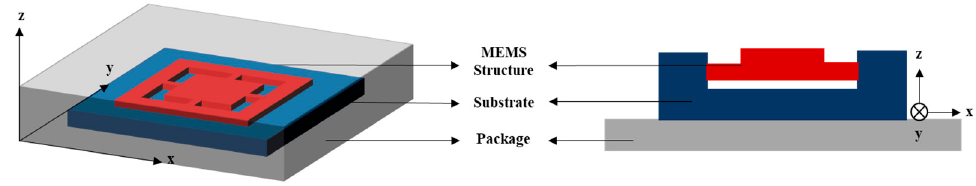
Figure 2. Package-substrate-microstructure model of MEMS devices.